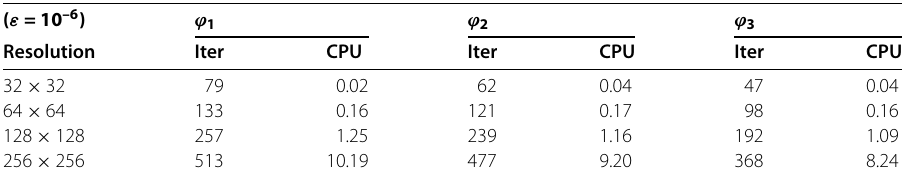
Table 4 The performance of the obstacle SOR applied for nonlinear obstacle problems with ϕ = ϕ i , i = 1,2,3